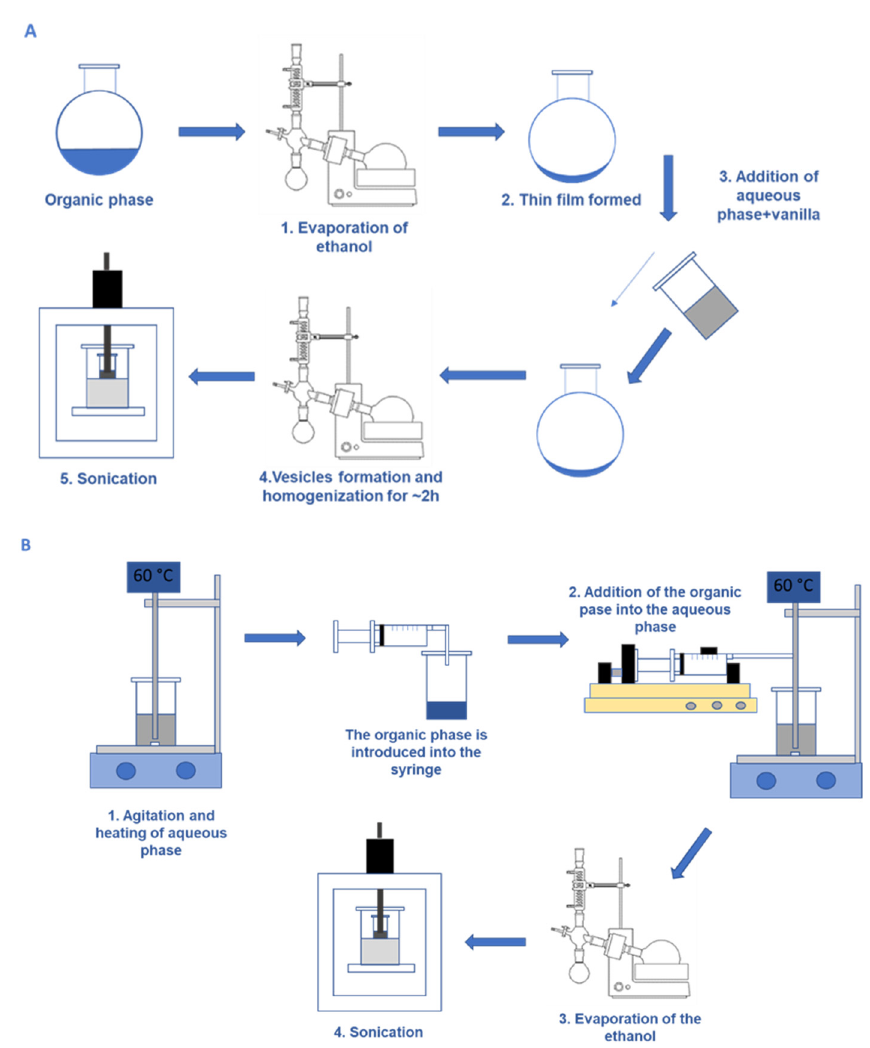
Figure 1. Schematic drawing of thin film hydration method ( A ) and ethanol injection ( B ) procedure used in the preparation of vesicles.